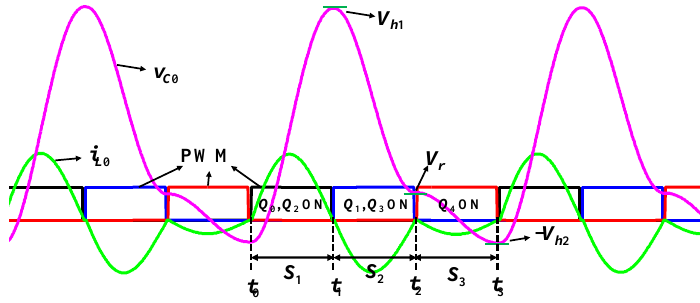
Figure 5. Theoretical waveforms of the capacitor voltage and the resonant current at V B 0 > V B 1 . Charge State S 1 [ t 0 - t 1 ]: At t 0 , switches Q 0 and Q 2 are turned ON with ZCS. The LC tank is connected with B 0 in parallel through Q 0 and Q 2 , as shown in Figure 3a. B 0 , L 0 , and C 0 form a resonant current loop. The capacitor C 0 is charged by B 0 . v C 0 increases from − V h 2 , which is a remnant of C 0 from